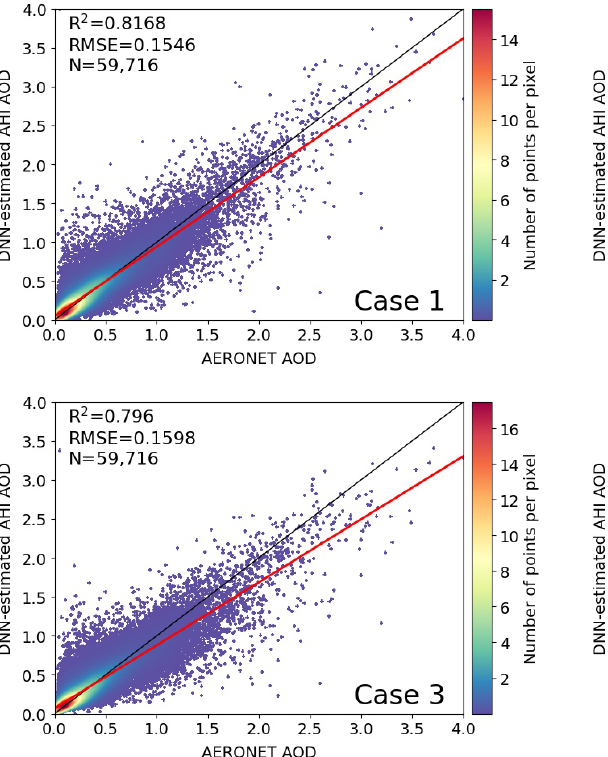
Table 4. R 2 and RMSE of 8 cases with different input meteorological features.